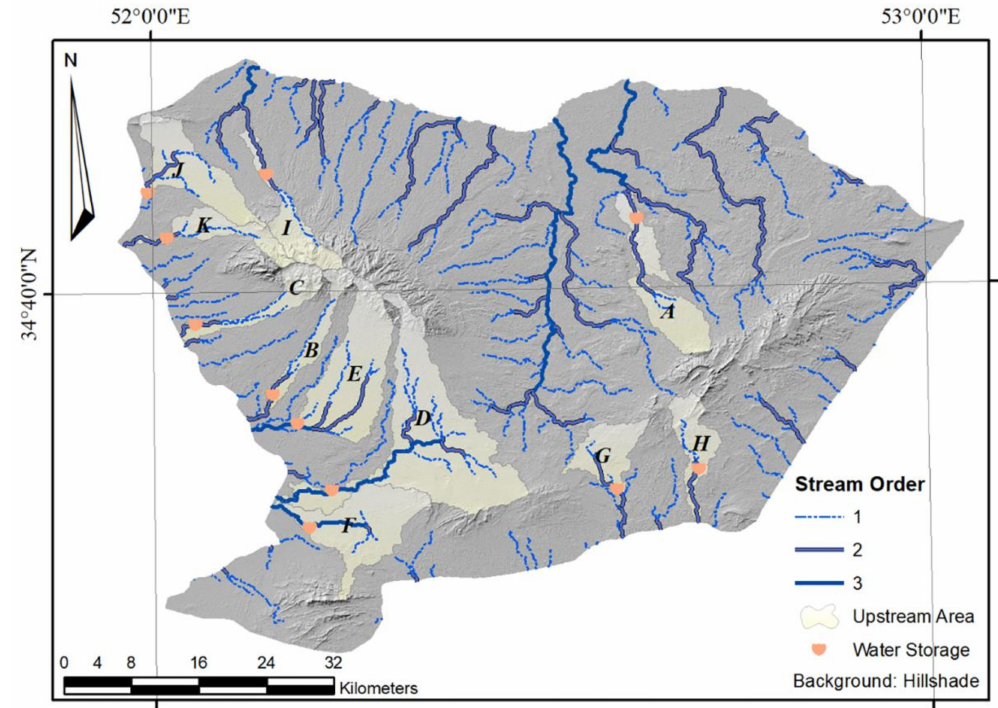
Figure 14. Possible locations for runo ff harvesting structures in Kavir National